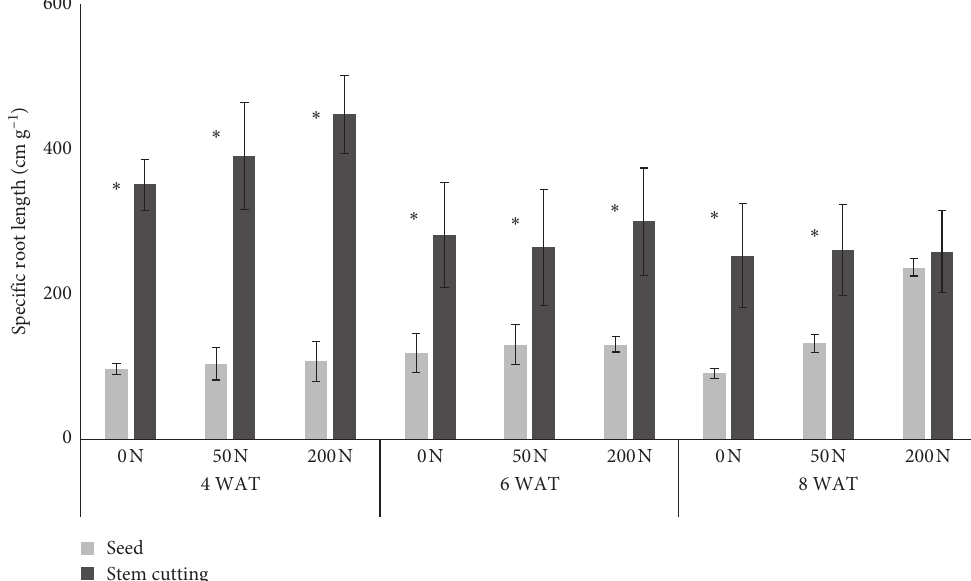
Figure 9: Specific root length (cm g − 1 ) of E. pellita seedlings from seeds and stem cutting plant materials at different nitrogen concentrations (0, 50, and 200kg N ha − 1 ) at three selected dates of root measurement: 4 weeks after transplanting, WAT, 6 WAT, and 8 WAT. The mean values were tested using independent samples t -test between seed and stem cutting propagation for each fertilizer treatment and date. All mean values were significantly different ∗ ( P < 0 . 05). Error bars denote standard deviations of the mean ( n �